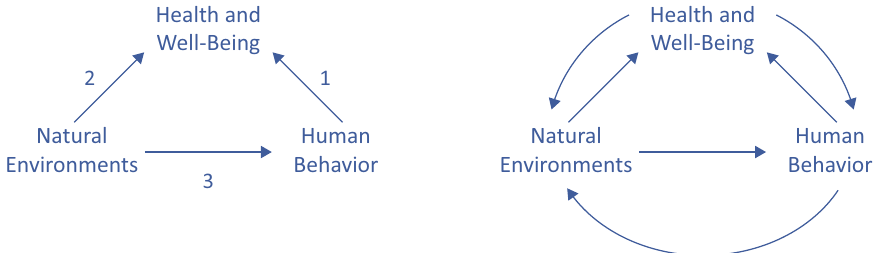
Figure 1. From linear causality to systems thinking. Notes: The relations between positive health effects of some human behaviors (physical activity, social interaction, leisure) on health (shown as 1) have been reported by empirical research. The positive impact of natural environments on human health (shown as 2) has been assumed and studied by many unco‐ ordinated studies in the social and psychological sciences, but the accumulated evidence remains unclear. There is very little coordinated empirical research (shown as 3) that concludes that natural environments are the enablers of health‐ promoting human behaviors that promote positive health outcomes. A systemic conceptual framework (shown on the right) should replace the linear causality (shown on the left) that has dominated contributions to